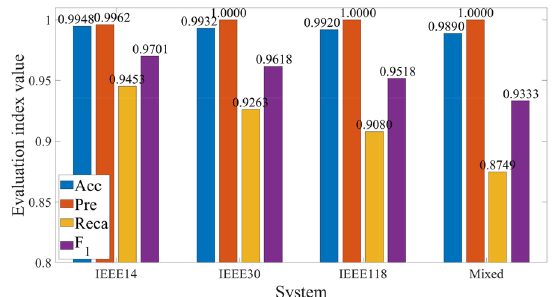
Fig. 8 Scalability performance on different